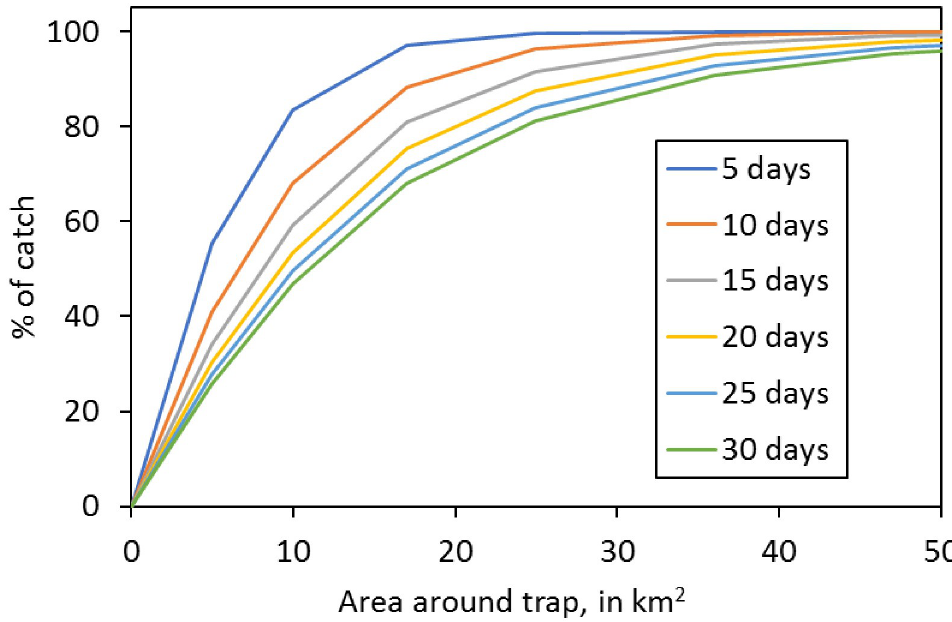
Fig 4. Percentage of the catch originating from various circular areas around a single trap after different numbers of days of trapping.